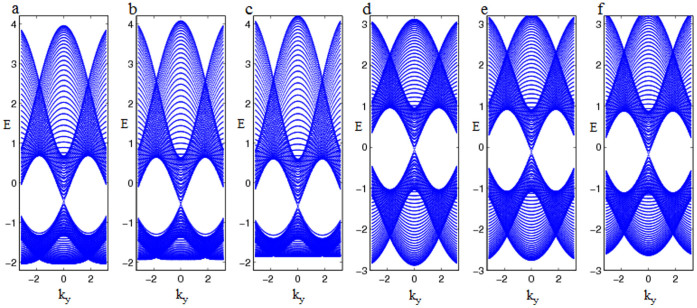
Energy spectrum of the armchair edged graphene with the 1NN hopping t1 and the different 2NN hopping t2.Note that surface states emerge in figures (a, b, c), while figures (d, e, f) show the absence of surface states. (a) t2 = 0.16t1. (b) t2 = 0.18t1. (c) t2 = 0.2t1. (d) t2 = 0.02t1. (e) t2 = 0.04t1. (f) t2 = 0.06t1.